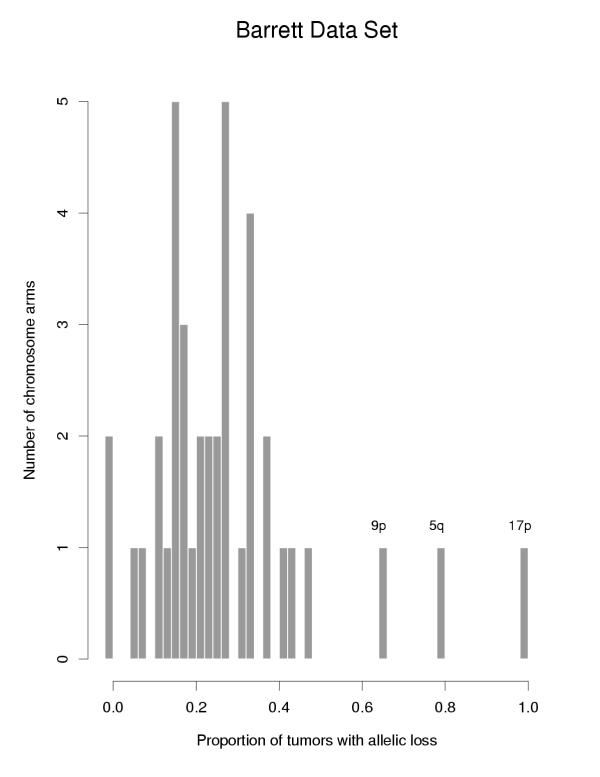
Histogram of allelic loss for the Barrett data set